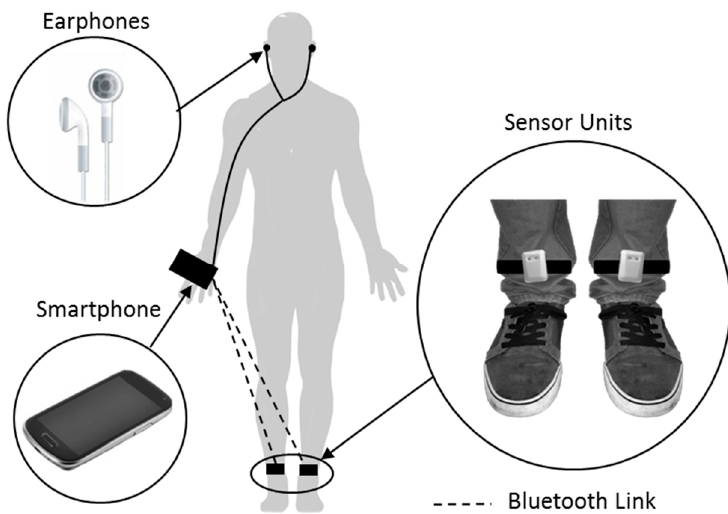
Figure 6. Illustration of a user wearing the GaitAssit system. Wired earphones were placed in the user’s ear, two sensor unit are attached to each lower leg and a smartphone (Samsung S3 mini) with auditory cueing application was worn on-body. The smartphone connected to each sensor unit over a Bluetooth classic communication link.